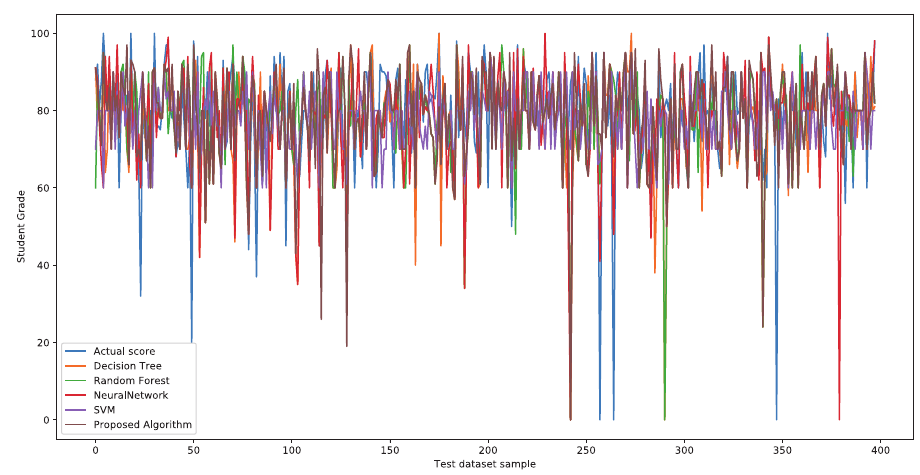
Figure 10. Predicted results of percentile